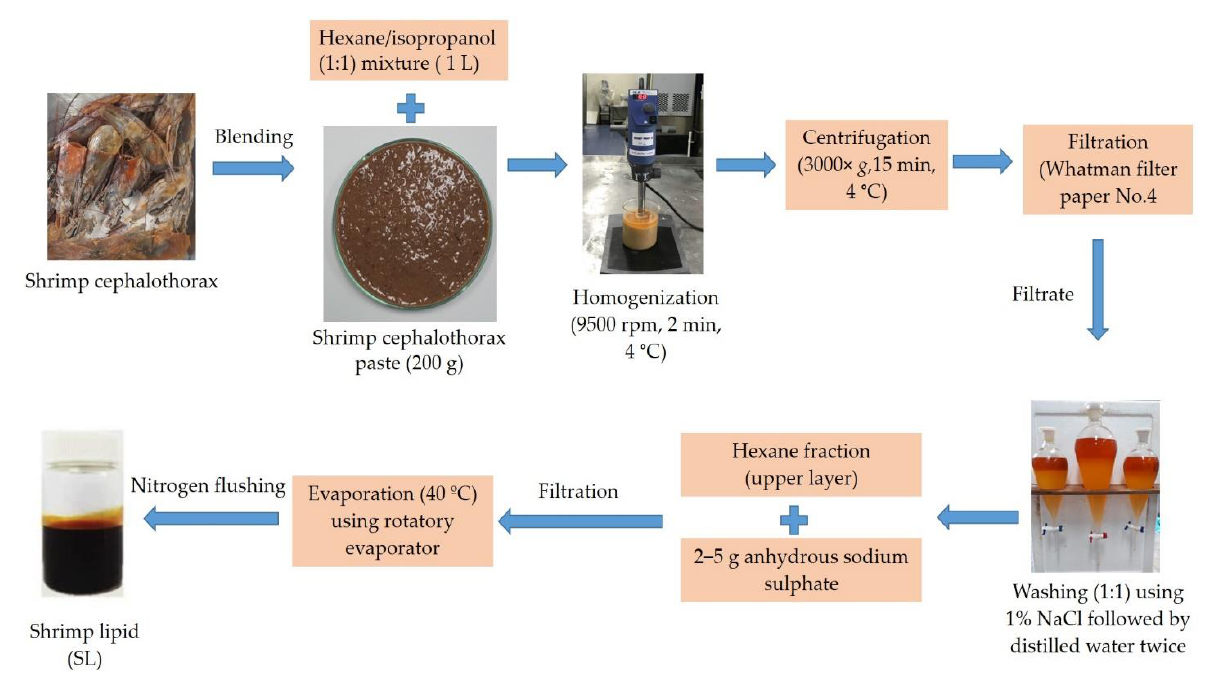
Figure 1. Preparation of shrimp lipid (SL) from shrimp cephalothorax. Table 1. Fatty acid profile and astaxanthin content of lipids extracted from the cephalothorax of Pacific white